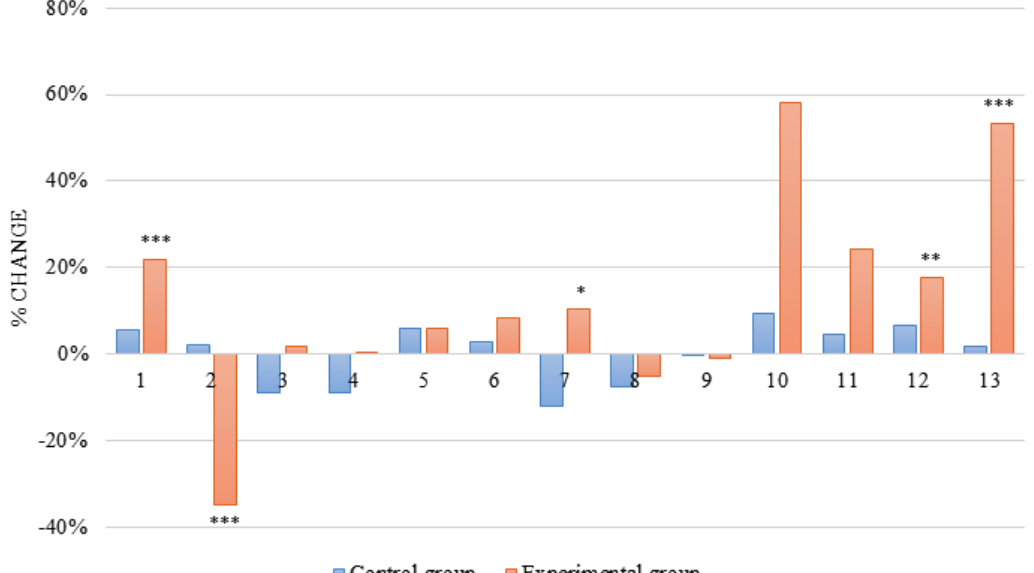
Fig. 1. The gain of physical fitness indicators in females at the end of the research, % Note: 1 – PWC capacity index; 3 – right hand dynamometry; 4 – left hand dynamometry; 5 – standing high jump; 6 – standing long jump; 7 – push-ups; 8 – 4x9 m shuttle run; 9 – 30 m run; 10 – Romberg’s test; 11 – bends; 12 – abdominal strength; 13 – back muscular strength; * Р<0,05, ** Р<0,01, *** Р<0,001 in comparison with indicators of females from CG at the end of the